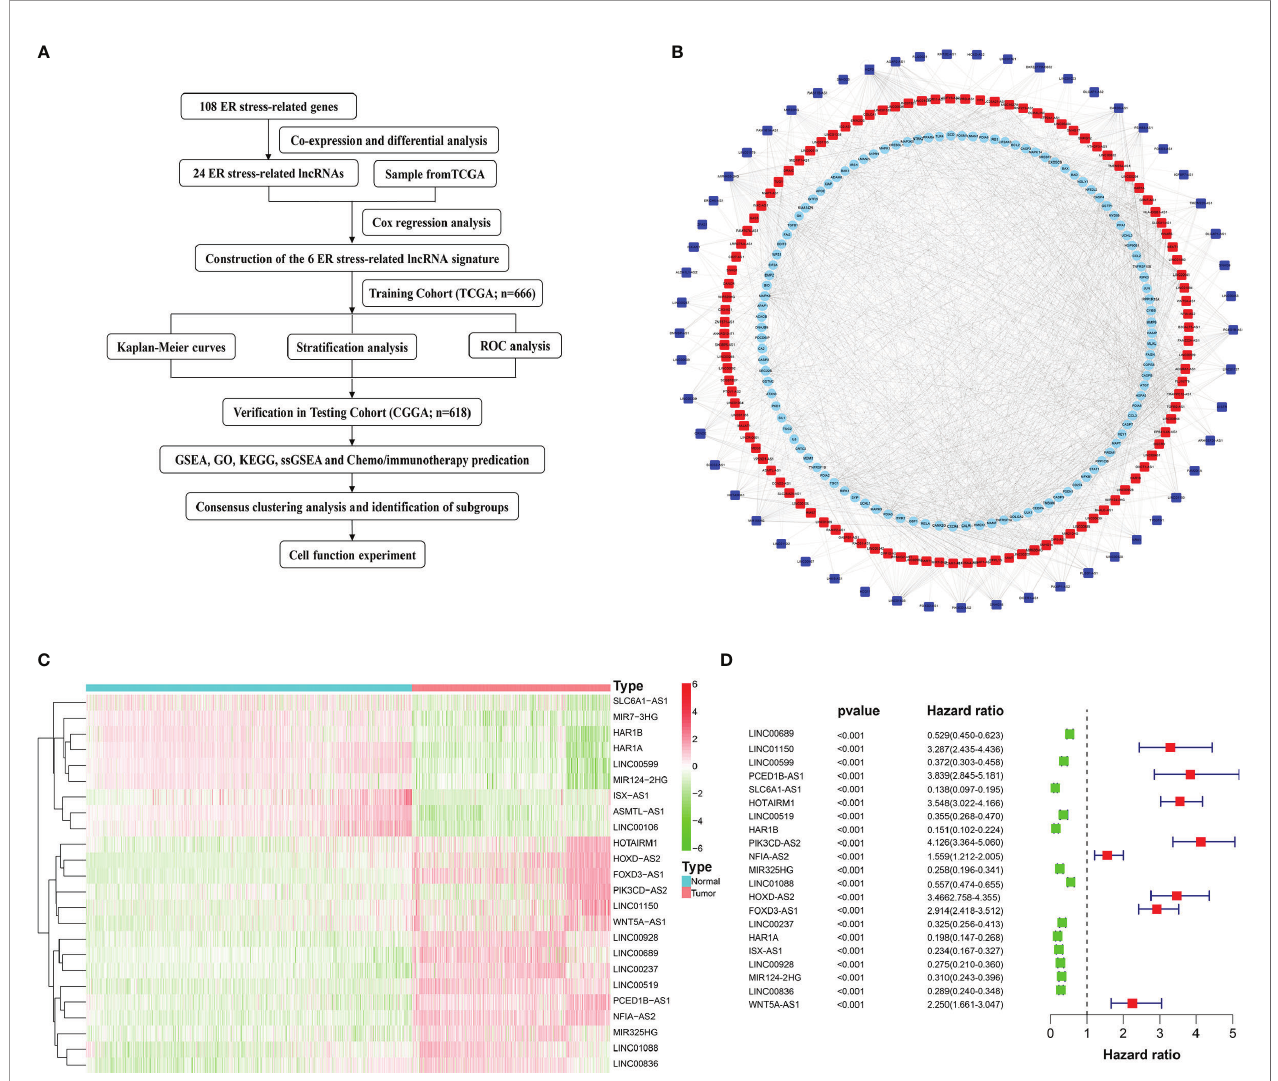
FIGURE 1 | Flow diagram and the acquisition, identi fi cation, and screening of ER stress-related lncRNAs. (A) Flow chart of this study. (B) ER stress-related lncRNAs and ER stress-related genes interaction network. Squares represent ER stress-related lncRNAs and circles represent ER stress-related genes. Red indicates positive correlation and blue indicates negative correlation. (C) Heatmap of 24 differentially expressed ER stress-related lncRNAs. (D) Univariate Cox regression